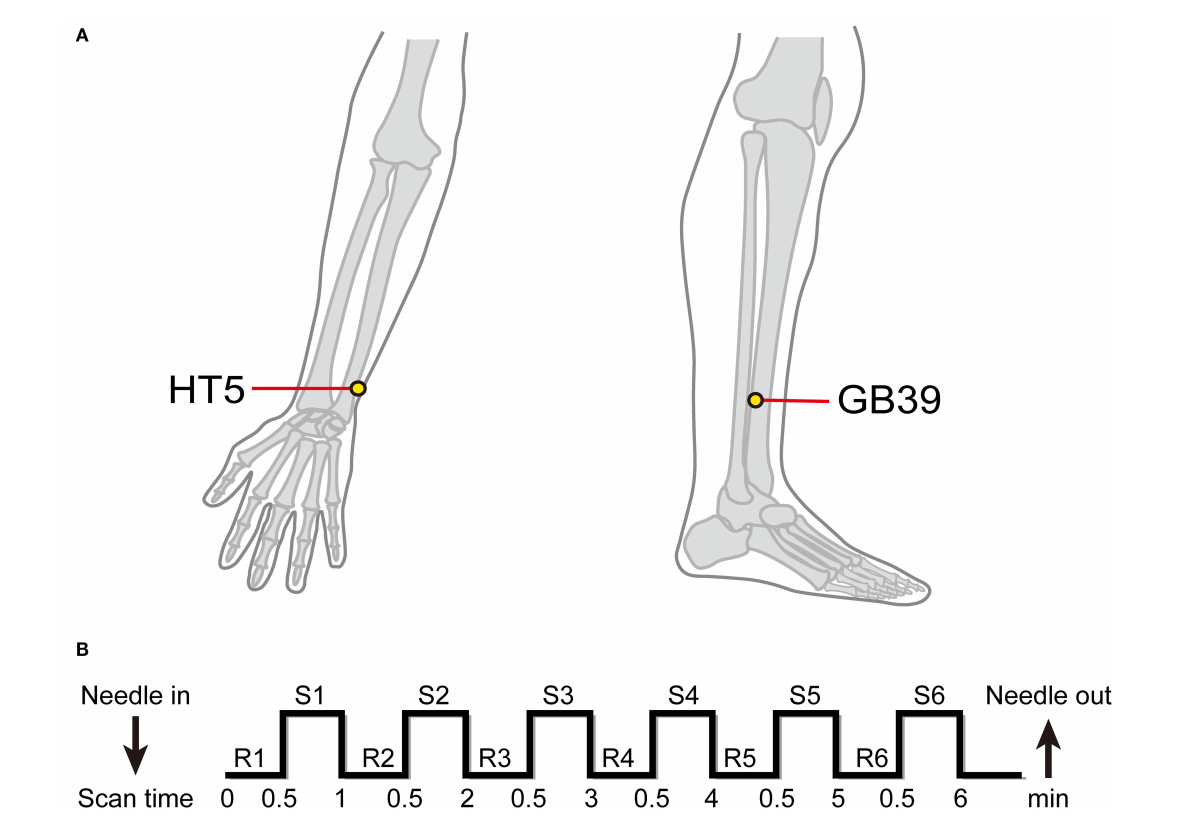
FIGURE2 Location of acupuncture points and electroacupuncture stimulation procedure. (A) Location of HT5 and GB39. (B) n-Block design of task-based fMRI. R, rest; S, stimulation.